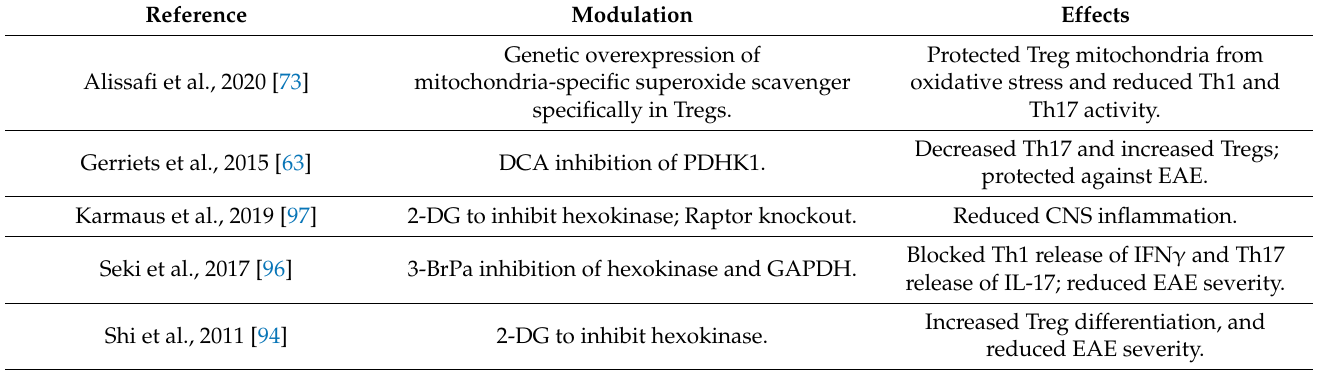
Table 2. Amelioration of EAE through metabolic modulation of